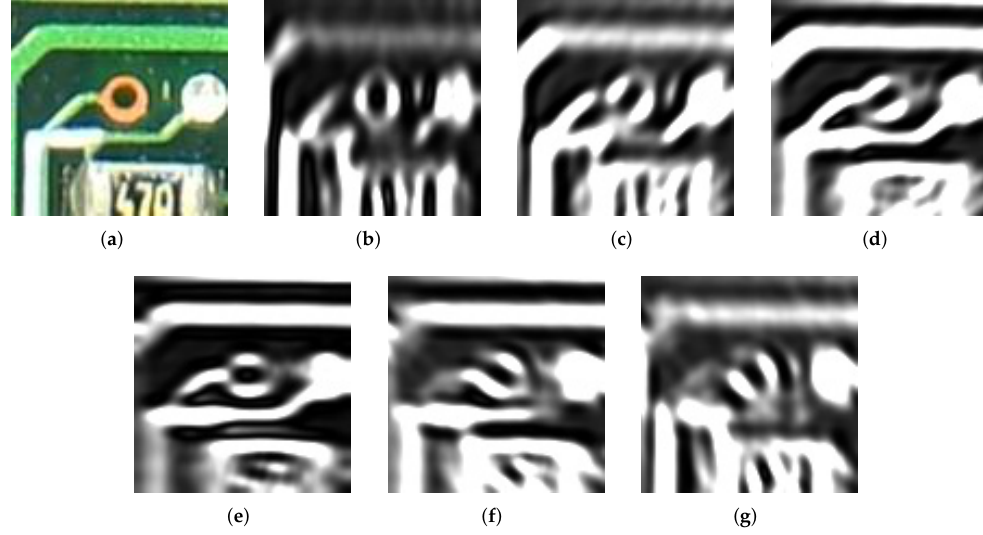
Figure 9. ( a ) A part of the original PCB image; ( b ) filtered image when θ = 0 ◦ ; ( c ) filtered image when θ = 30 ◦ ; ( d ) filtered image when θ = 60 ◦ ; ( e ) filtered image when θ = 90 ◦ ; ( f ) filtered image when θ = 120 ◦ ; and ( g ) filtered image when θ = 150